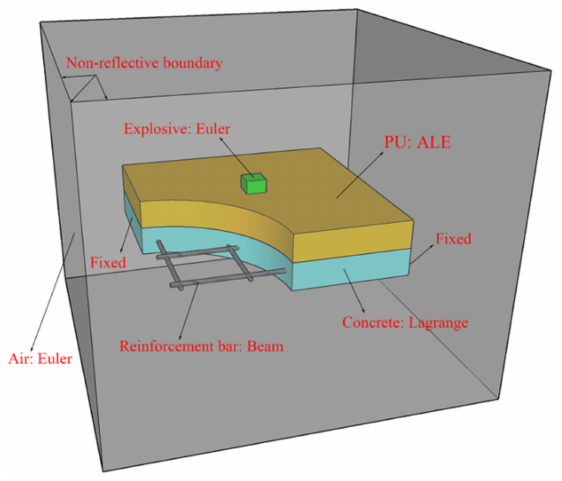
Figure 11. ALE coupling